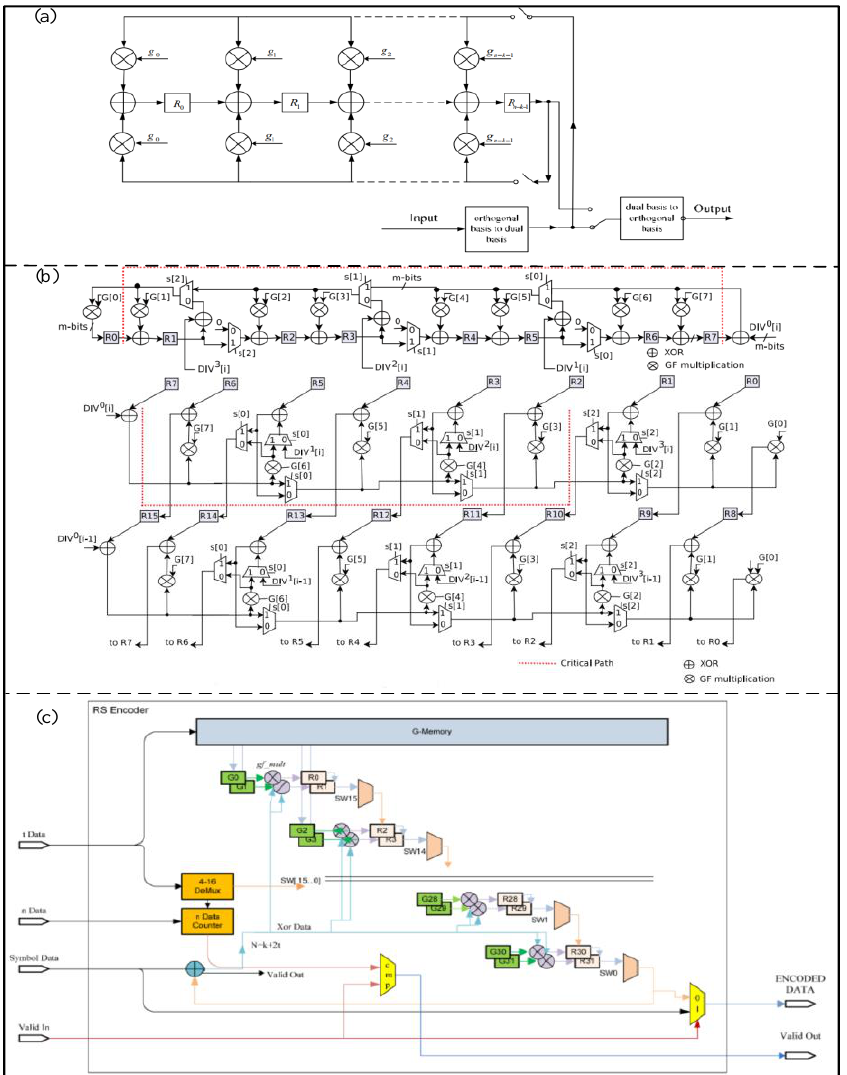
Figure 2. ( a ) Architecture of dual basis RS encoder. (Reprinted from [26], Copyright 2009, with permission from IEEE). ( b ) Circuit implementation of the vector string/parallel divider RS encoder. (Reprinted from [27], Copyright 2019, with permission from Elsevier). ( c ) Architecture of variable-rate RS encoder. (Reprinted from [30], Copyright 2011, with permission from